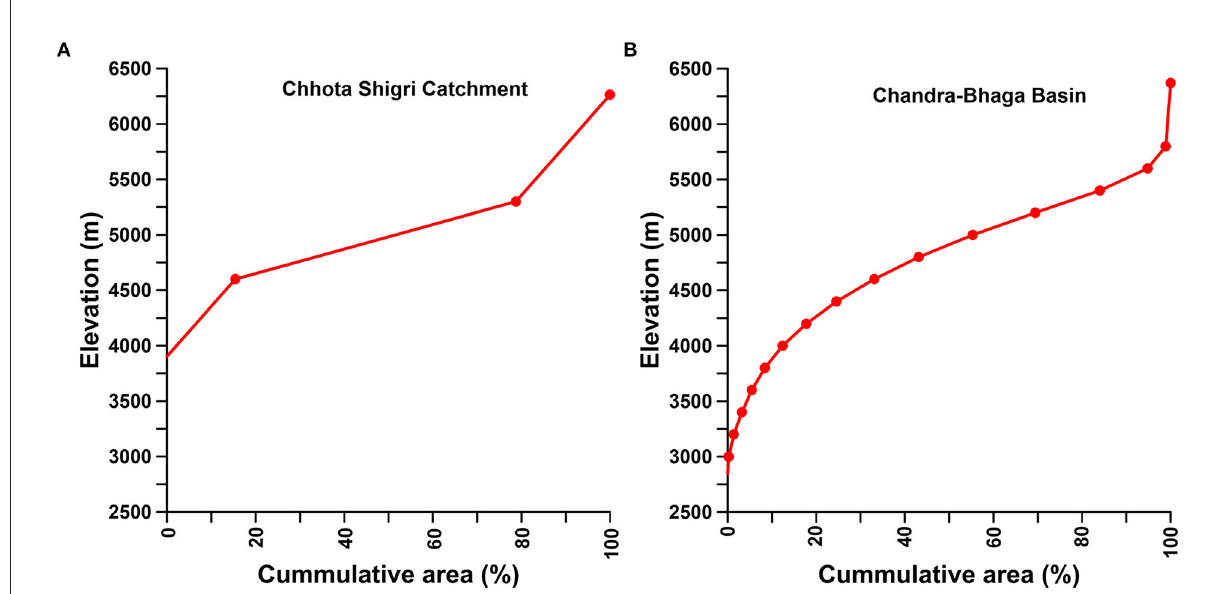
FIGURE2 Hypsometry curve for Chhota Shigri Catchment (A) and Chandra-Bhaga Basin (B) showing the area distribution over the different elevations. Points represent the maximum elevations for each zone and cumulative percentage